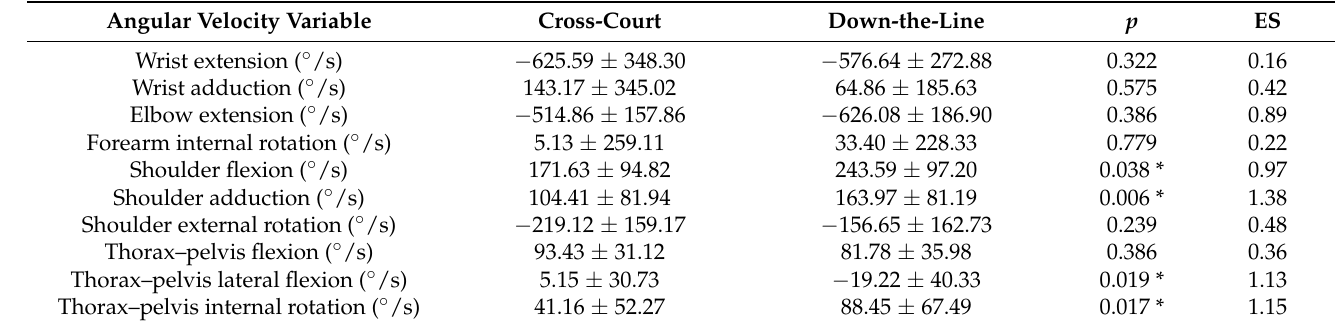
Table 4. The angular velocity biomechanical variables of upper body at the impact ( n = 8).